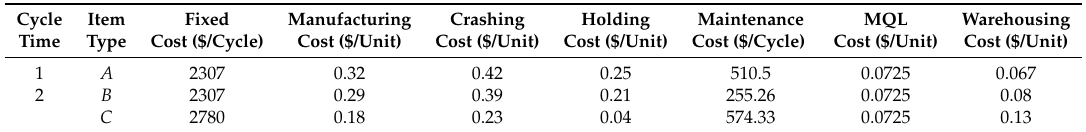
Table 3. Manufacturing